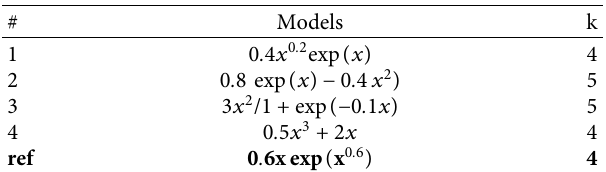
Figure 3: Model selection performances for two levels of additive noise:15% top and 30% bottom. For each level of noise, the top plots show in black the synthetic data generated with the reference equation of Table 2. The coloured curves are the various candidate models and in dashed point green is the reference one. The bottom plots are the comparison of AIC and AIC MICx results in terms of the difference with respect to the exact reference model. Table 4: Power law plus a squashing